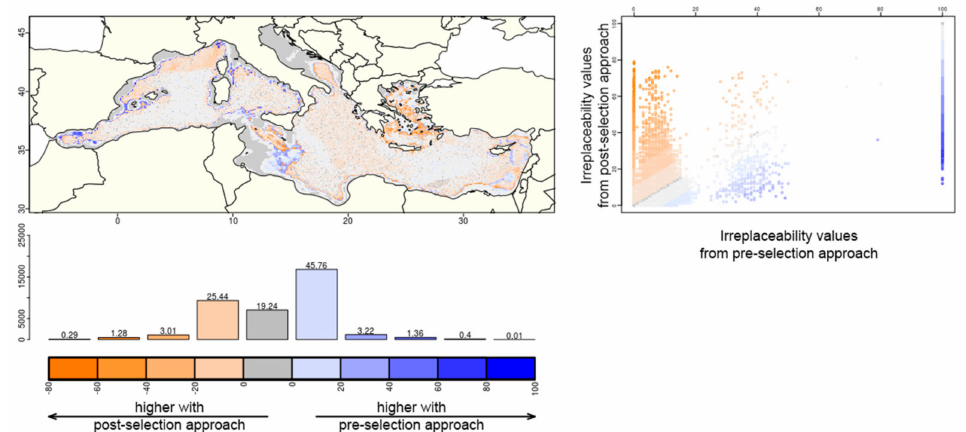
Figure 4. Comparison of priority ranking values based on the two approaches, including uncertainty associated with distribution modeling. Map of difference in planning unit (PU) selection frequency. Scatter plot showing the PU selection frequency under the different approaches. Histogram of selection frequency differences.